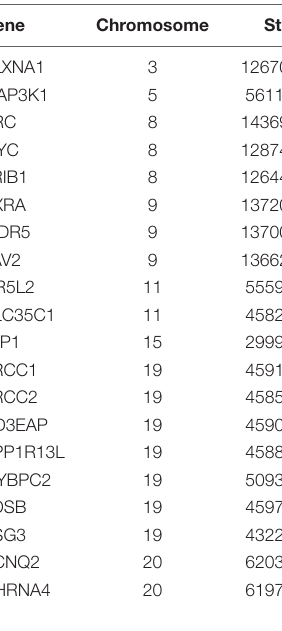
TABLE 2 | 20 candidate genes by gene ontology (GO) functional enrichment